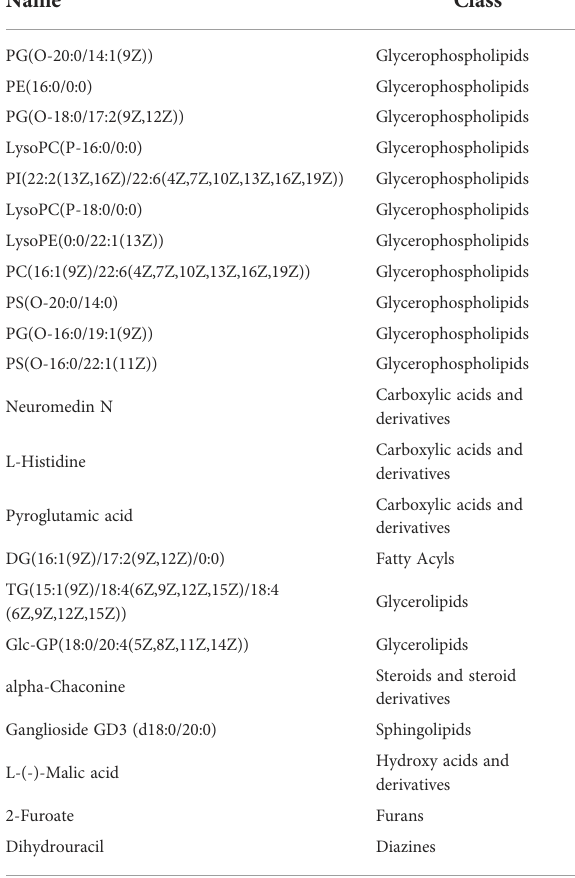
TABLE 1 The longitudinal trajectories of 22 signi fi cant metabolites in response to dulaglutide overlapped with those of T2D at baseline. Name